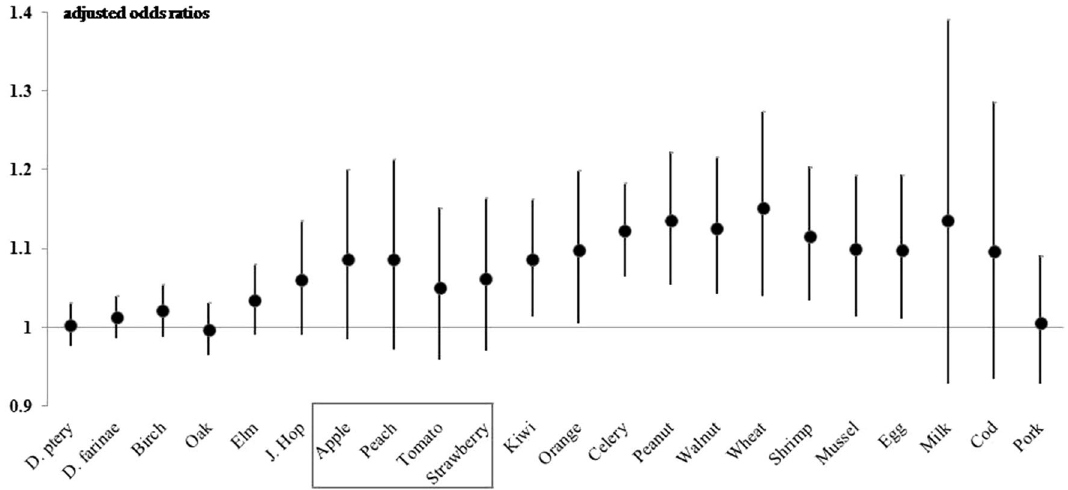
Figure 2. Adjusted odds ratios (with 95% confidence intervals) of the association of sensitization to individual allergens with serum LBP level. Adjusted for sex, age, body mass index z-score, parental asthma, allergic rhinitis, and atopic dermatitis, and household